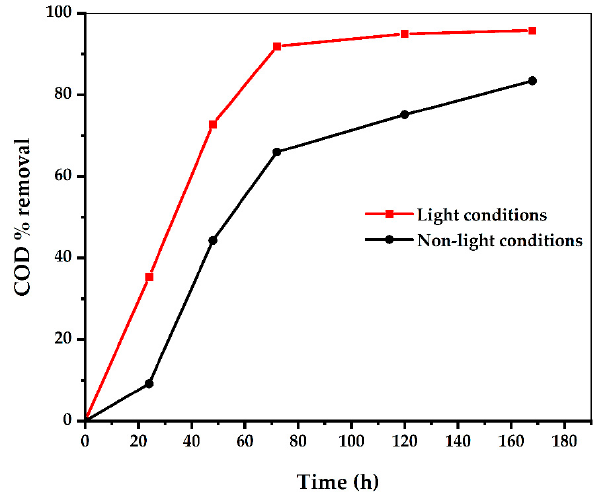
Figure 8. COD removal over time in MFC with the Li 0.95 Ta 0.76 Nb 0.19 Mg 0.15 O 3 cathode in the presence and absence of a light source.